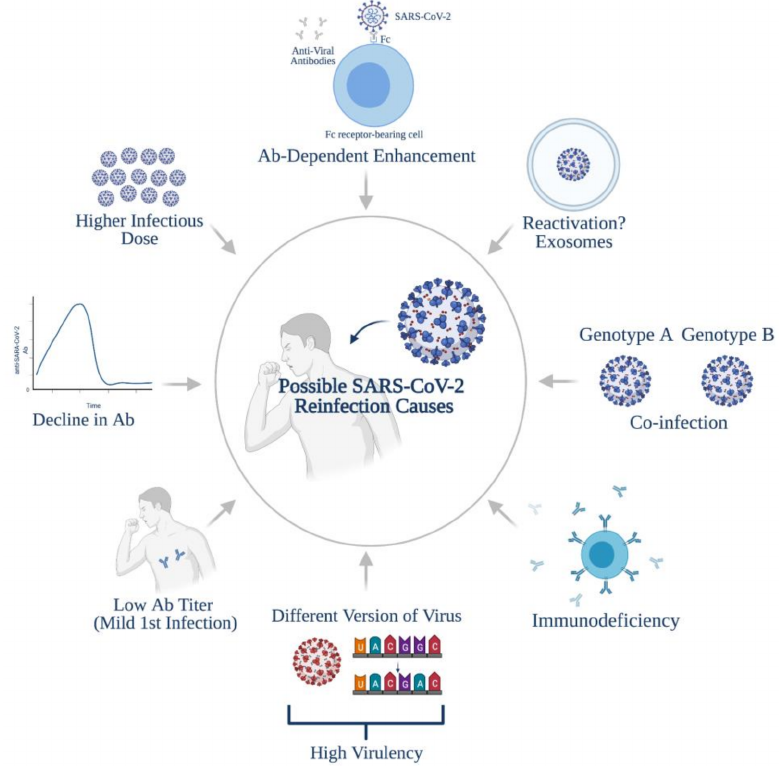
Figure 1. Possible causes of SARS-CoV-2 reinfections. Created using